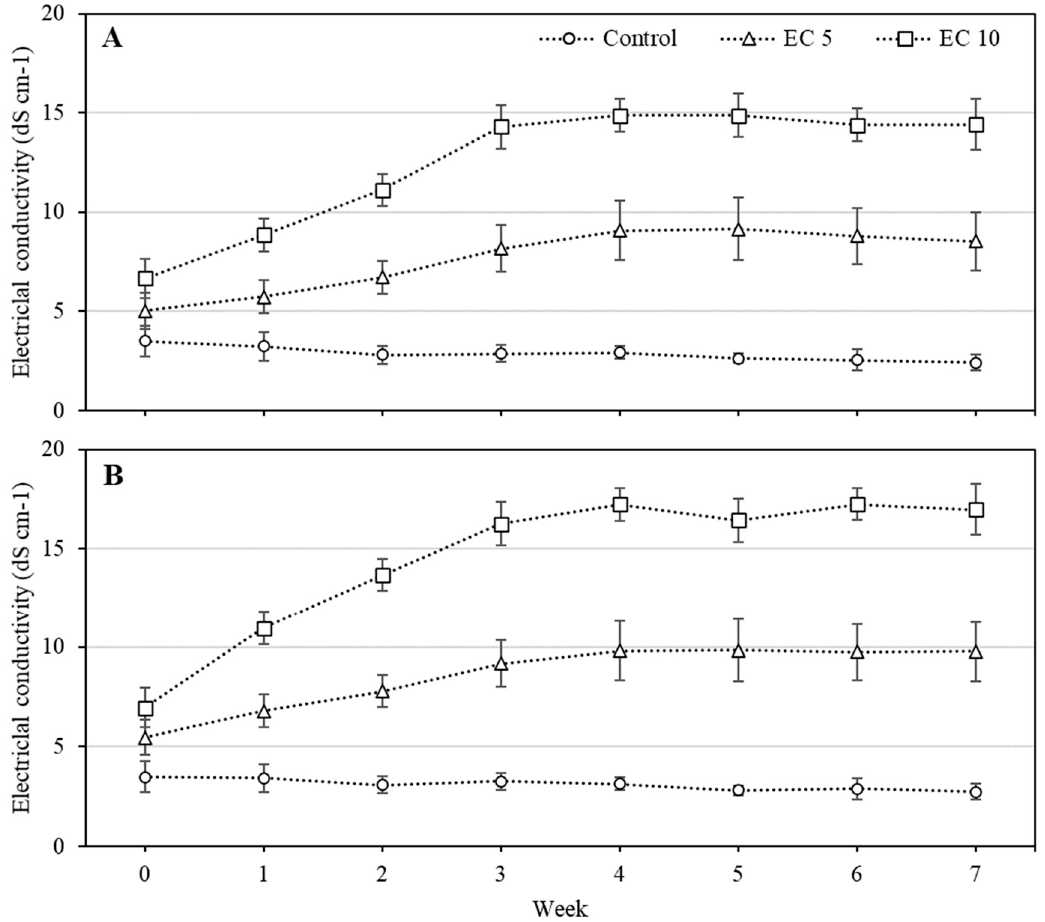
Figure 1. Leachate electrical conductivity (EC) in Experiment 1 ( A ) and Experiment 2 ( B ). Control represents a nutrient solution at an EC of 1.0 dS · m − 1 ; EC 5 represents a saline solution at an EC of 5.0 dS · m − 1 ; and EC 10 represents a saline solution at an EC of 10.0 dS · m − 1 . Vertical bars represent standard deviation.